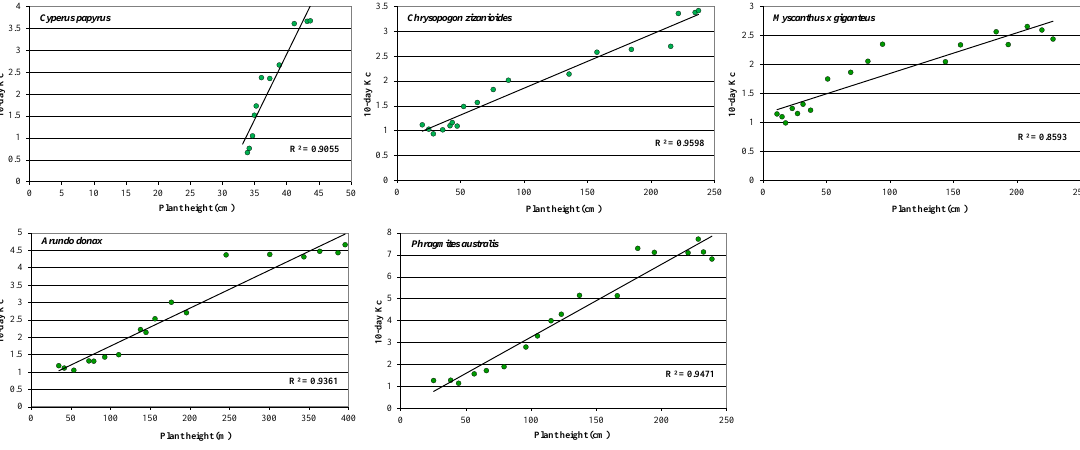
Figure 12. Relationship between 10-day K c and plant height for C. papyrus , V.zizanioides , M. giganteus , A. donax, and P. australis from April to September 2012.